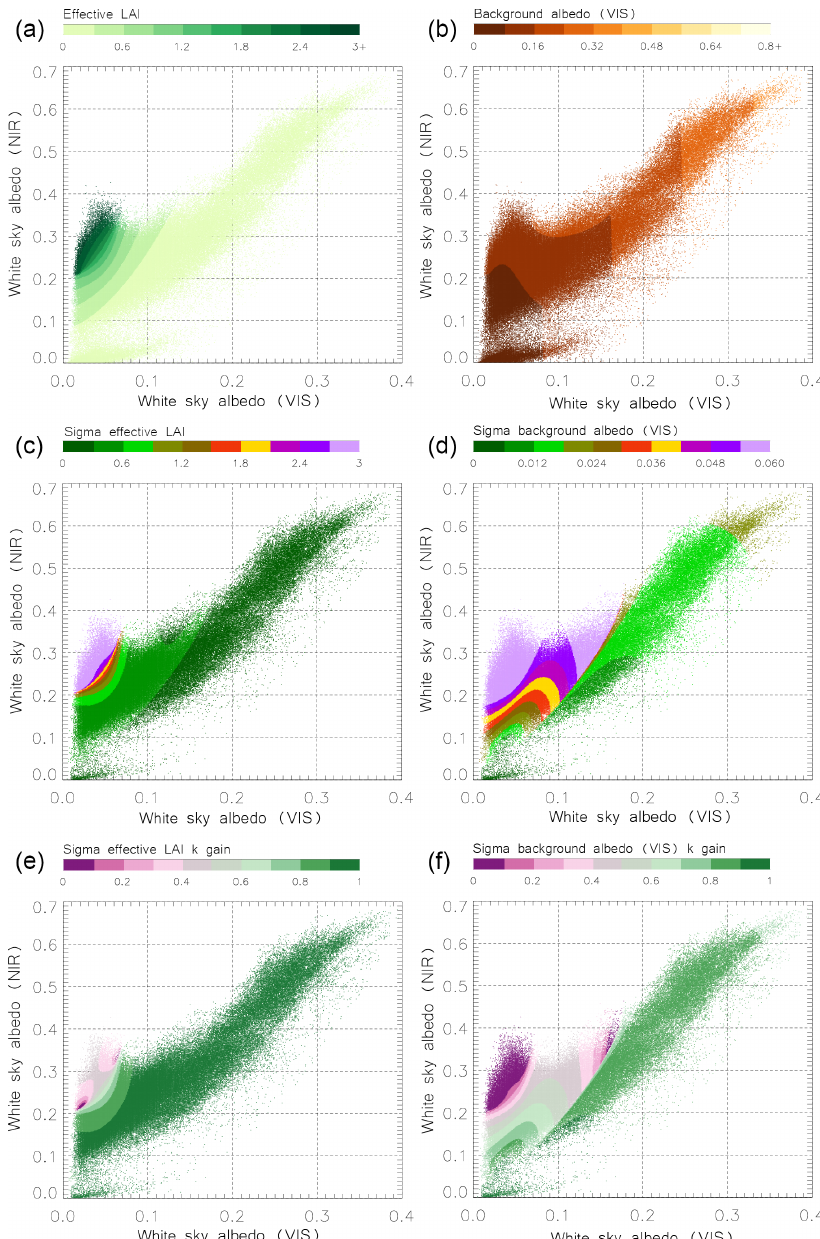
Figure 4. Mean value (upper panel), uncertainty (middle panel), and uncertainty reduction, denoted here as k gain for knowledge gain (bottom panel) of effective LAI (left) and background reflectance in the VIS